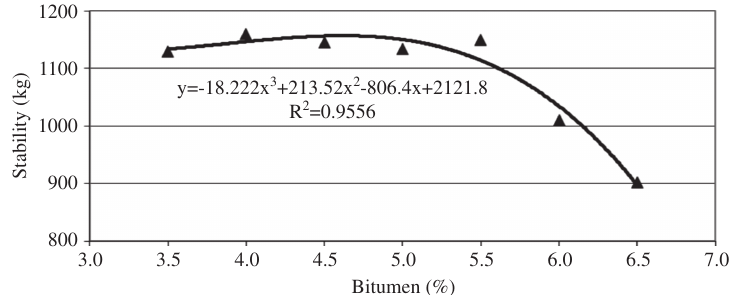
Figure 1 Marshall stability for bitumen content.